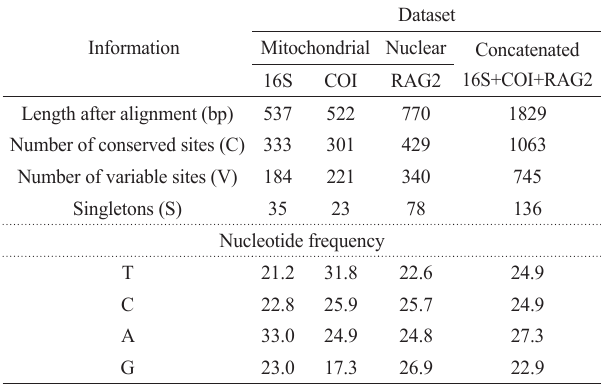
Tab. 2. Information content and characteristics of each dataset used in this study. Number of sequences = 205, bp = base pairs.